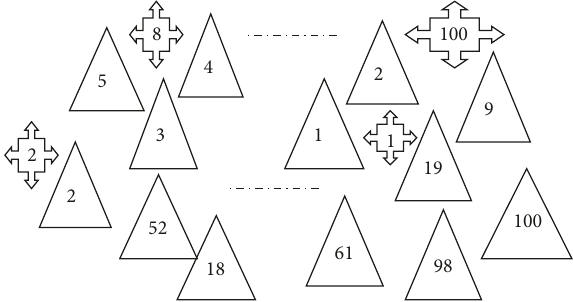
Figure 3: The possible arrangement of the proposed array of 100 earthquake stations and earthquakes in Uttarakhand region of Himalayas which is used to estimate lead times. EEW stations marked with triangles and the earthquakes by quad